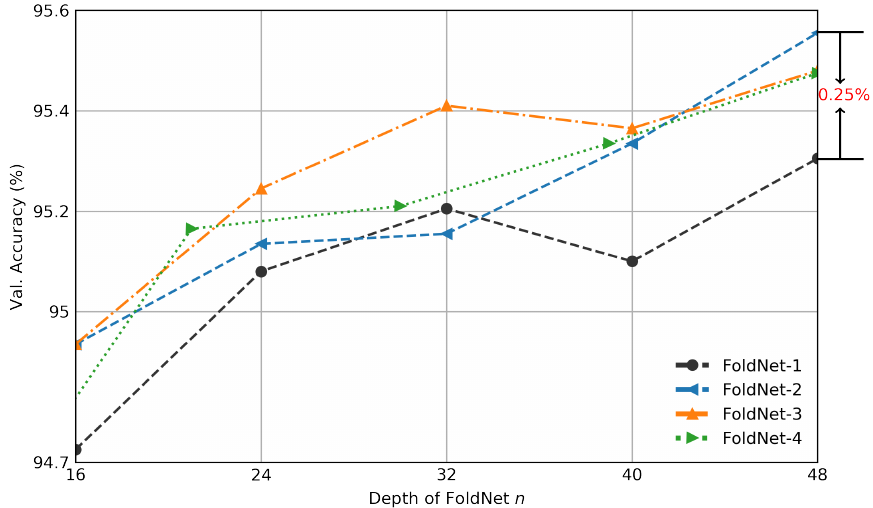
Figure 7. Validation accuracy of FoldNet- d for CIFAR-10 dataset when hidden dimension h = 256. x axis is the depth of neural network n , y axis is the validation accuracy percentage. The validation accuracy of FoldNet-2 increases by 0.25% compared with FoldNet-1 when depth n =